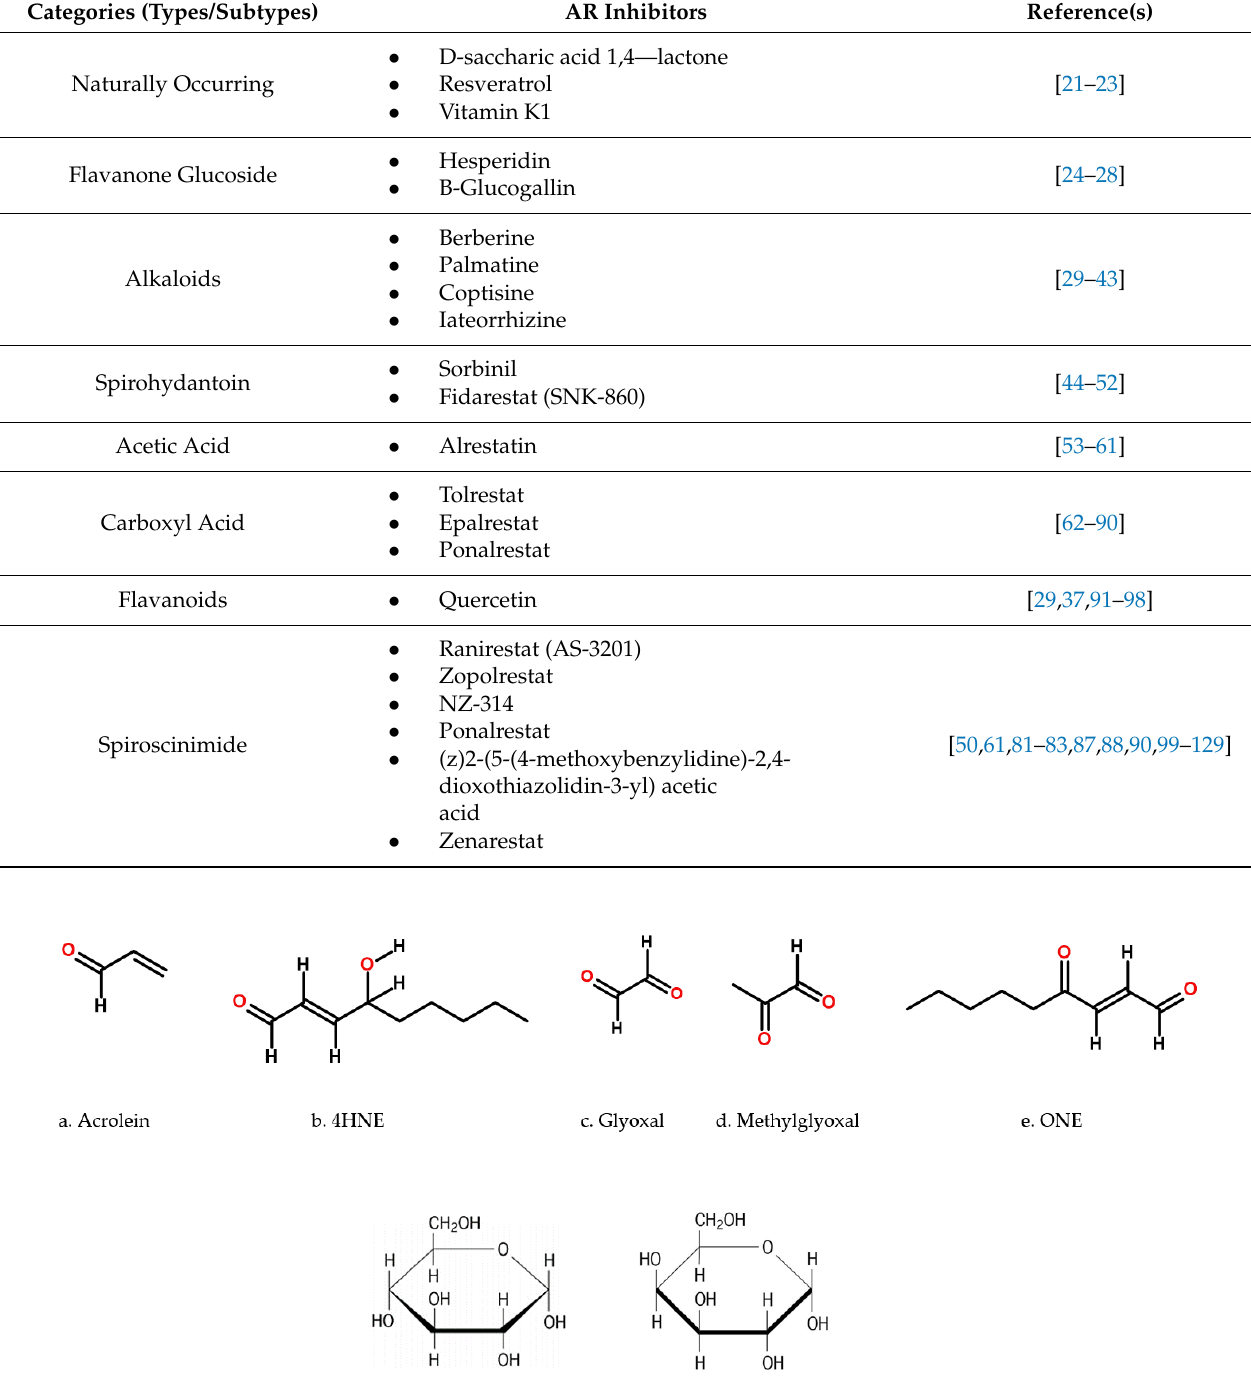
Figure 4. Chemical structure of major substrates metabolized by aldose reductase (AR) enzyme. ( a ). Acrolein (prop-2-enal), ( b ). HNE ((E)-4-hydroxynon-2-enal), ( c ). Glyoxal (oxaldehyde), ( d ). Methylglyoxal (2-oxopropanal), ( e ). ONE ((E)-4-oxonon-2-enal), ( f ). Glucose (6-(hydroxymethyl) oxane-2,3,4,5-tetrol), ( g ). Galactose ((3R,4S,5R,6R) -6-(hydroxymethyl)